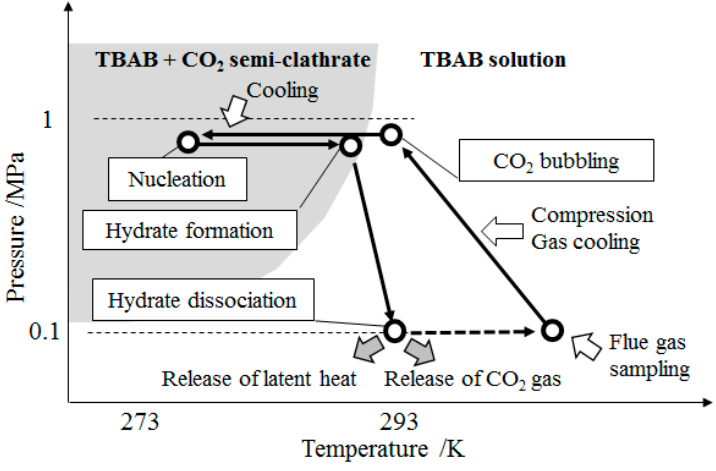
Figure 5. Conceptual diagram of semi-clathrate hydrate cycle.